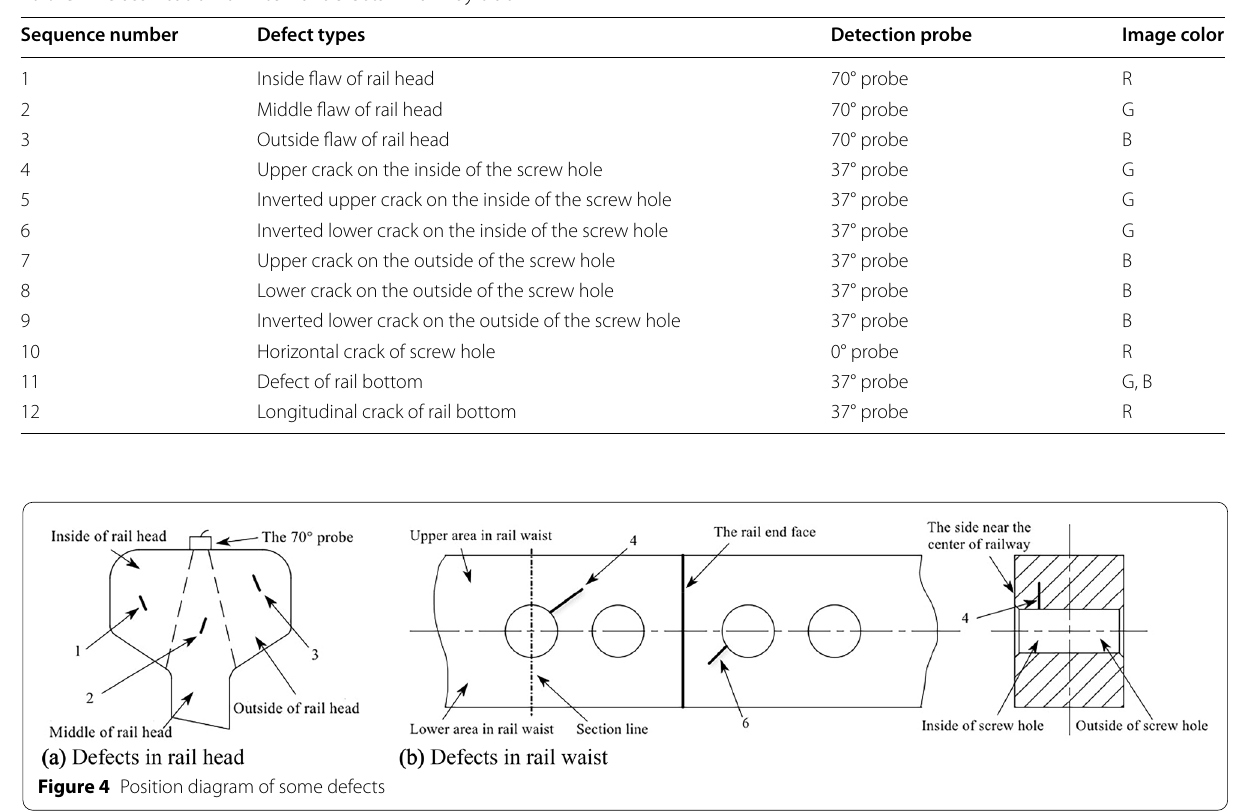
Table 1 Classification of internal defects in railway track